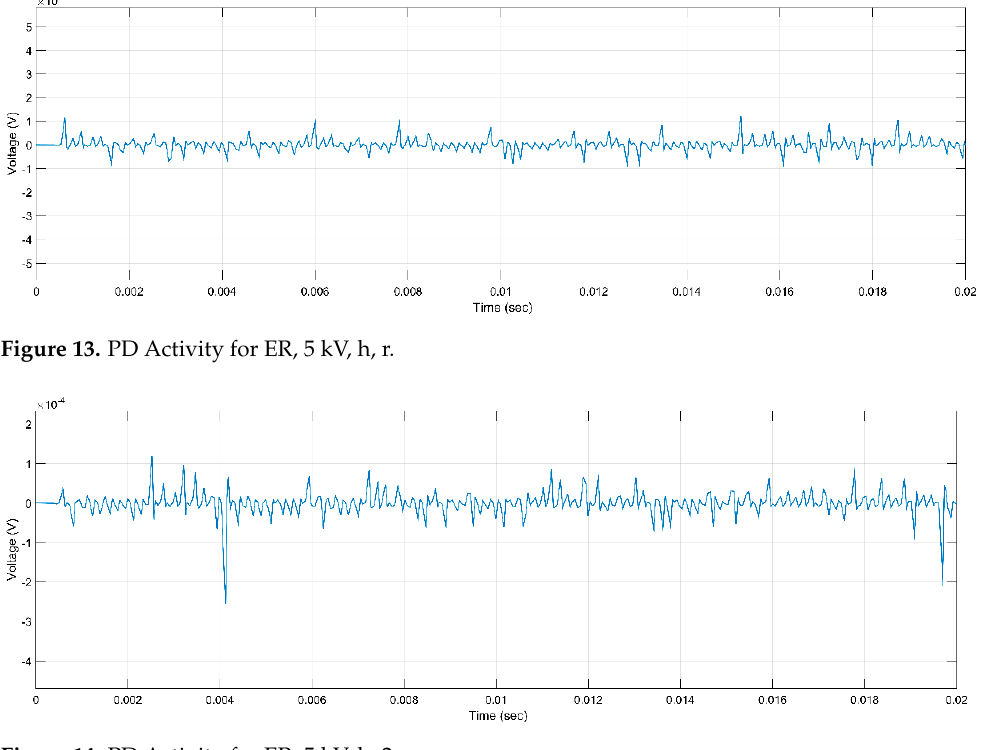
Figure 14. PD Activity for ER, 5 kV, h, 2 r.